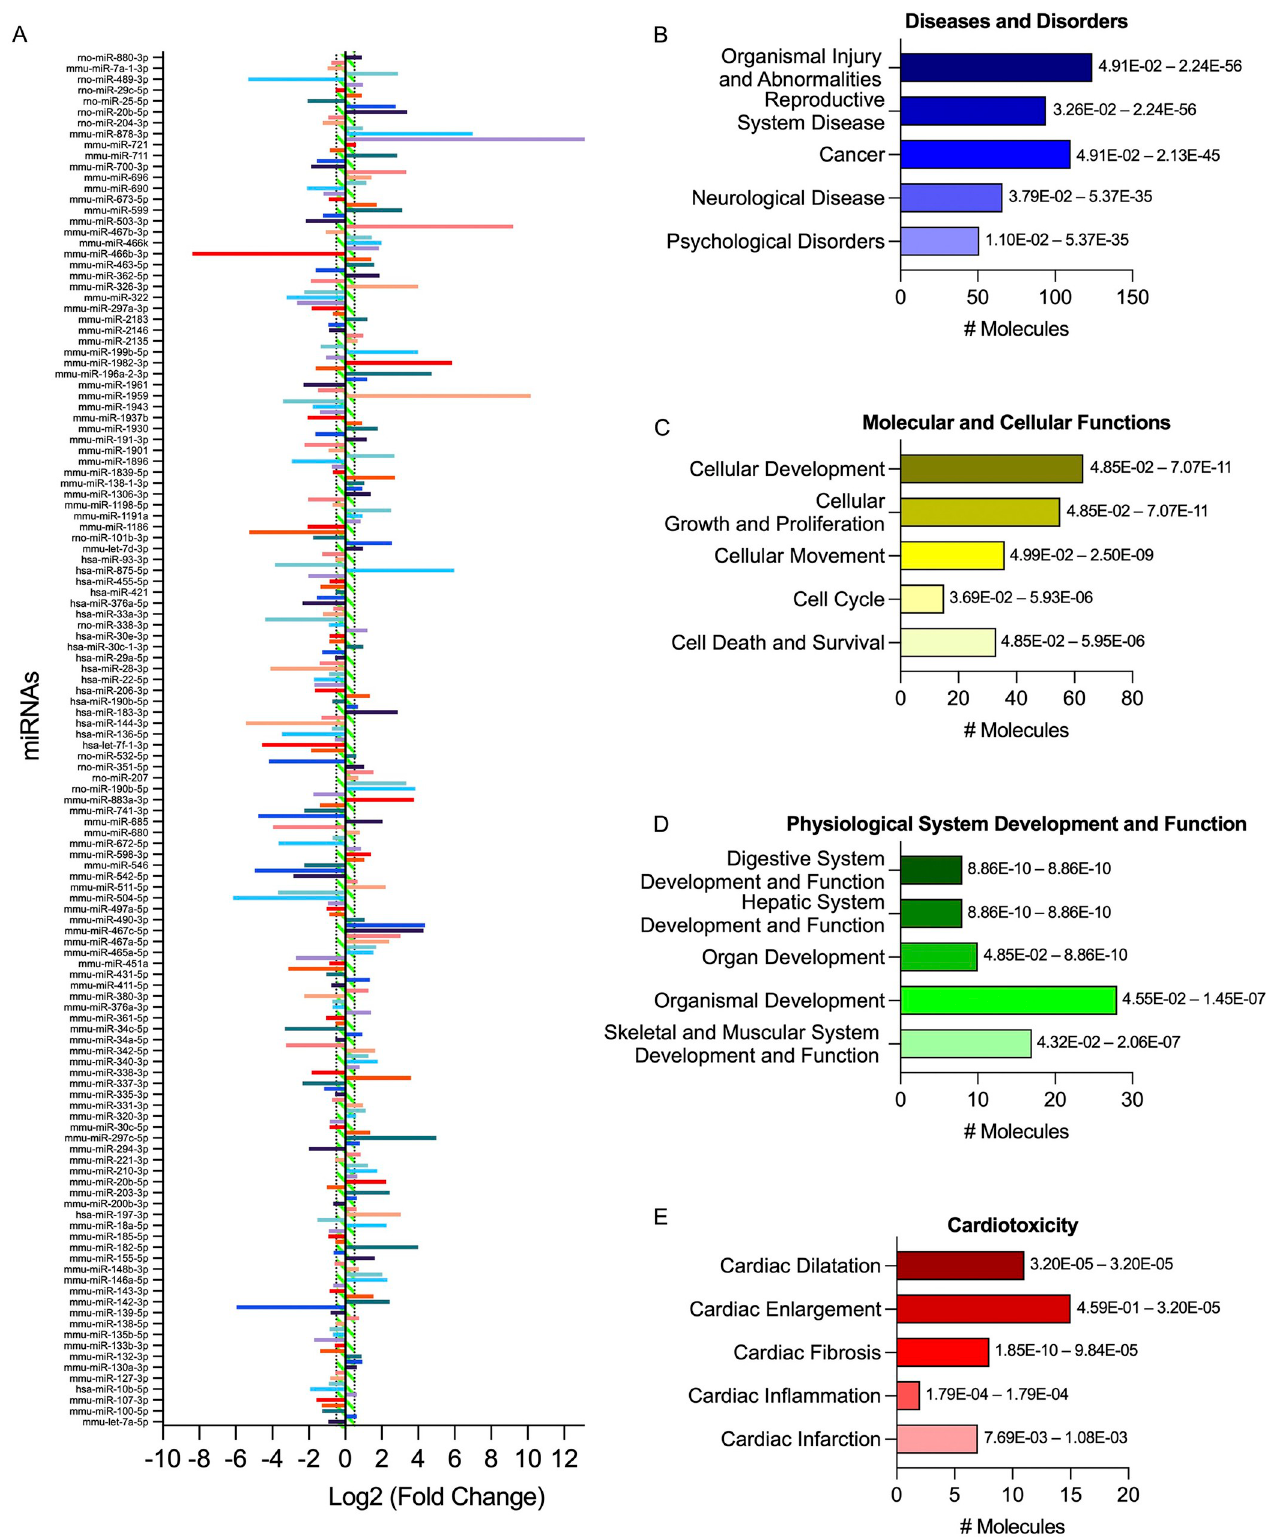
Fig 3. Characterization of the immune response expression profile for the chronically infected group. (A) Overall expression of the altered miRNAs. Results were expressed as log2 fold change, and genes with values greater than 0.5 or lower than -0.5 (1.5-fold change) (dotted vertical lines; green-striped area)